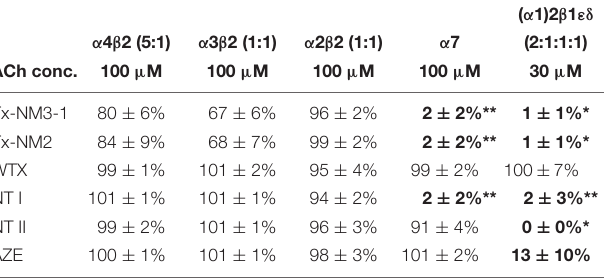
TABLE 1 | Normalized responses of human nAChR subtypes to the indicated acetylcholine (ACh) concentration after 3 min pre-incubation with 1 µ M of the indicated